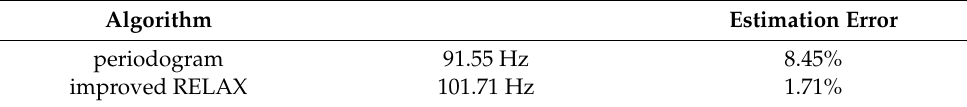
( b ) Figure 5. Estimation results of ( a ) periodogram and ( b ) improved RELAX algorithm.